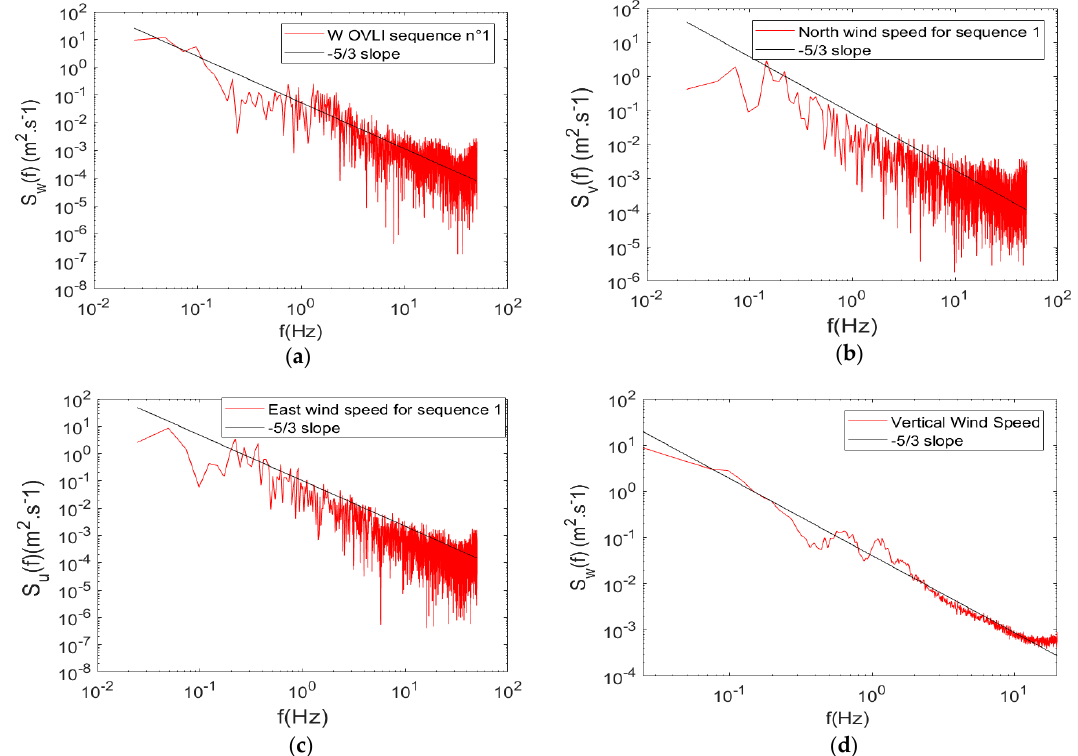
Figure 16. ( a ) Spectra of vertical wind speed, ( b ) north wind speed, ( c ) east wind speed, and ( d ) mean spectrum of vertical wind speed for all sequences. Note that the frequency scale is different on (d).